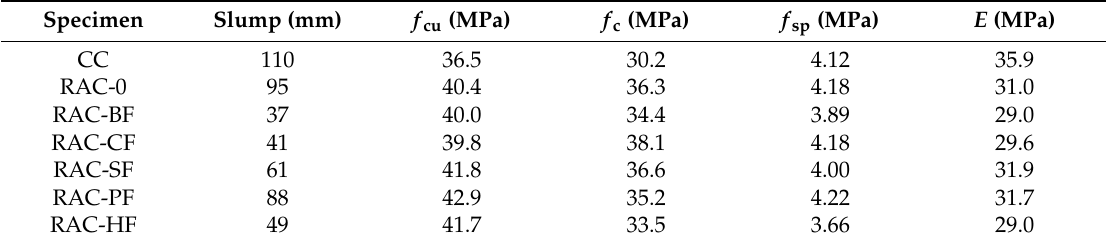
Table 5. Test results of different fiber-reinforced RAC specimens.